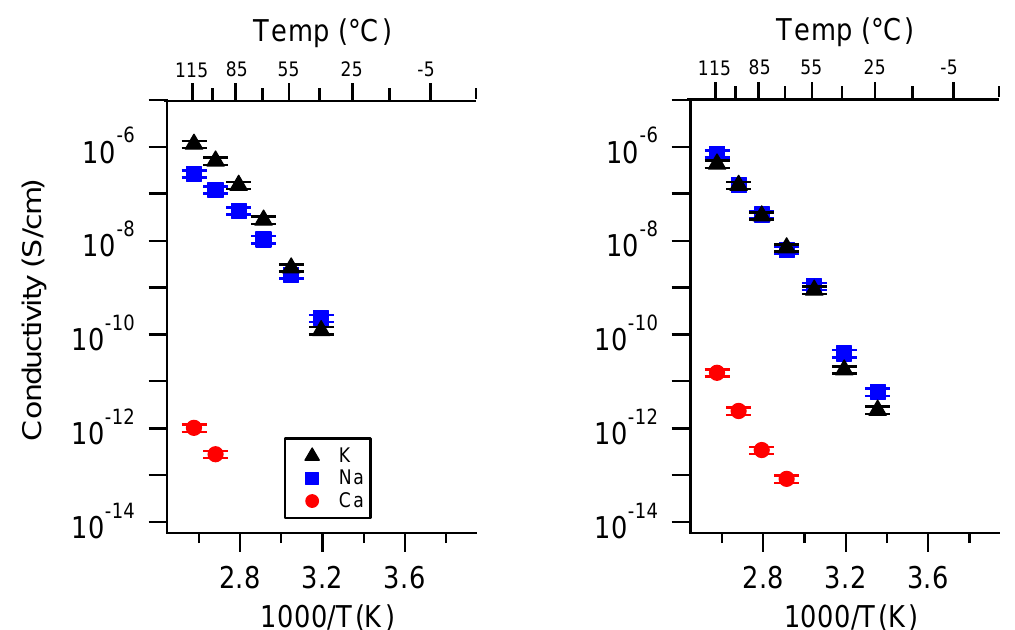
Figure A12. Conductivity as a function of cation for PEGDMA1000_high_SSM (left) and PTHFDA1000_high_STFSI (right) SIPEs dry. Temperatures ranged from − 20 °C to 115 °C. Note that there may be a non ‐ negligible fraction of electronic conductivity in conditions where conductivity of less than 10 − 9 S/cm is reported.